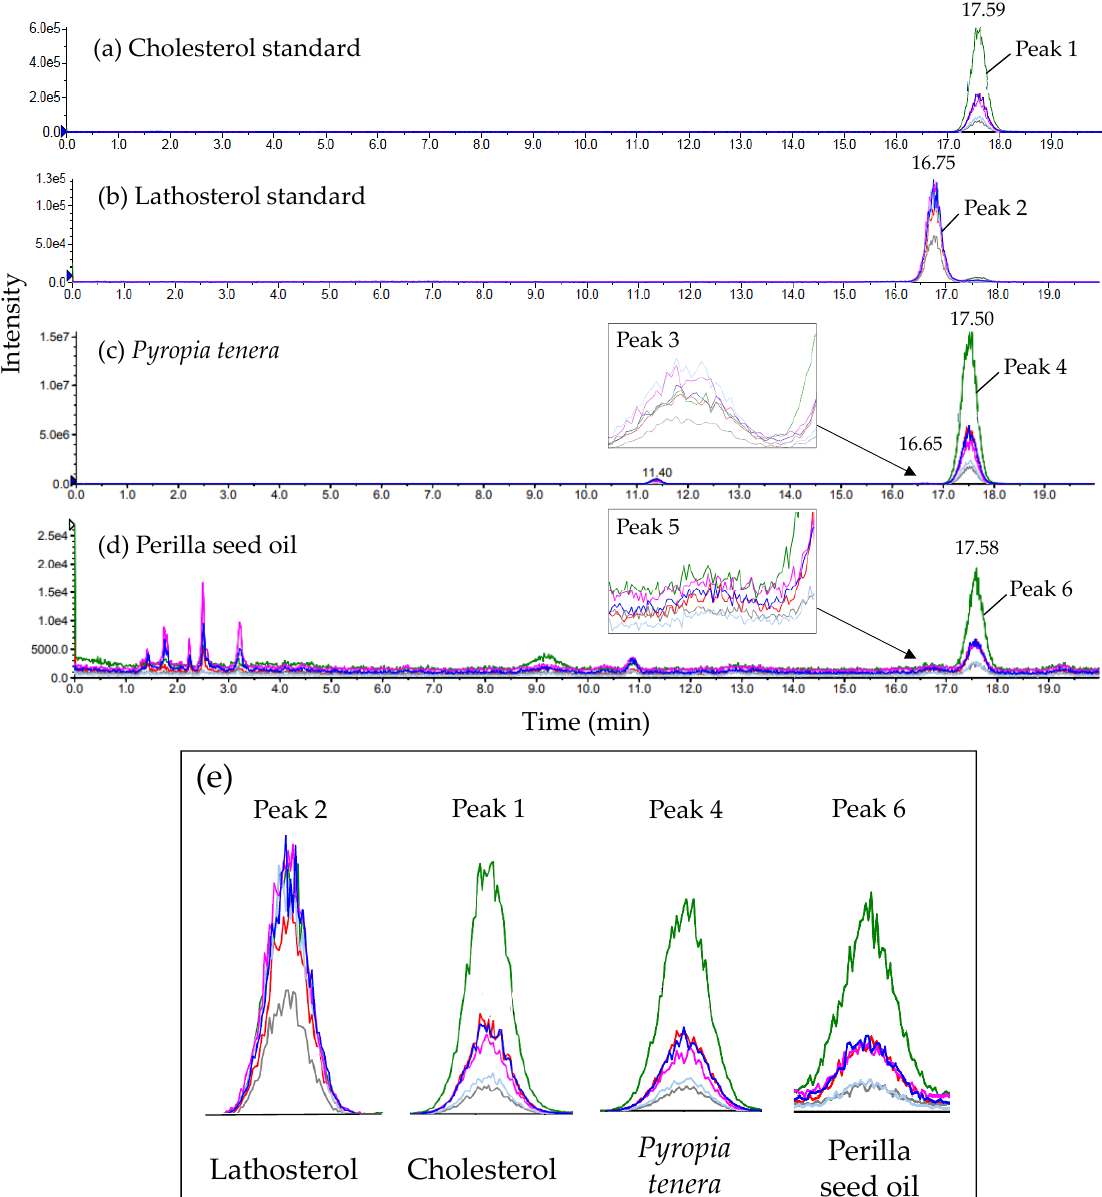
Figure 4. Multiple reaction monitoring (MRM) spectra of cholesterol standard ( a ), lathosterol standard ( b ), Pyropia tenera ( c ), perilla seed oil ( d ). Enlarged MRM spectrum of each peak 1, 2, 4, and 6 ( e ).